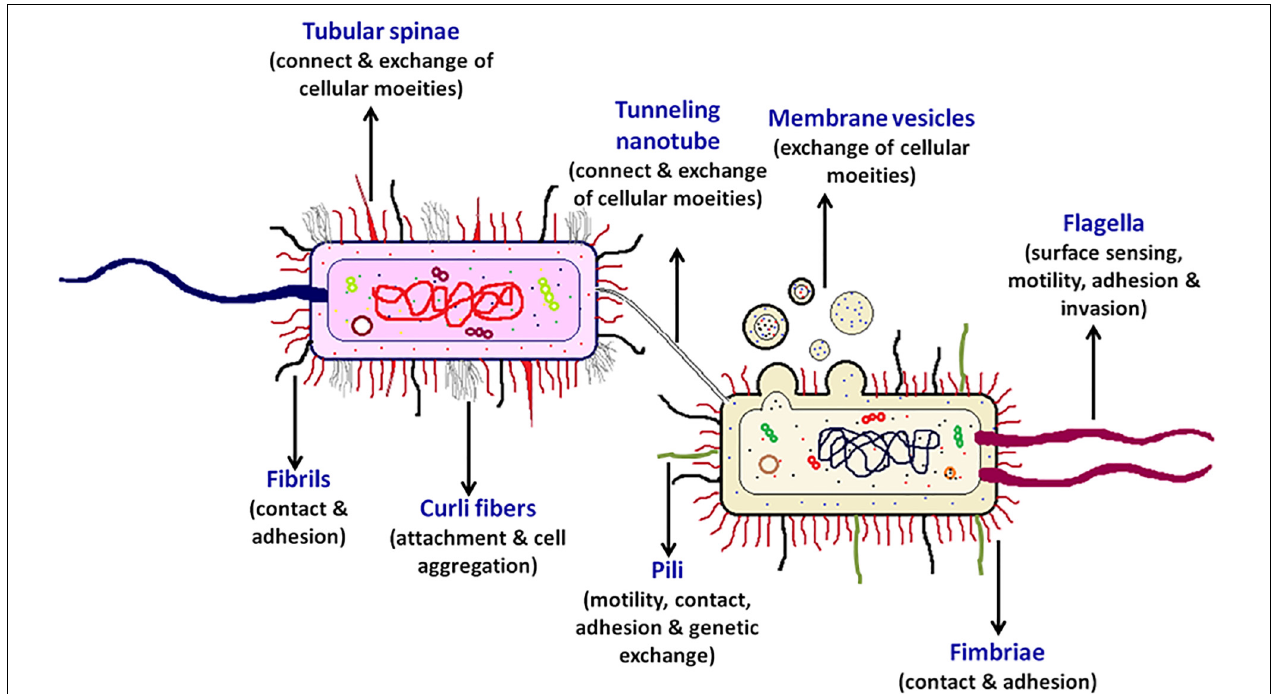
FIGURE 2 | Bacterial cell-surface appendages. Various proteinaceous tubular or fibrous structures are found extending from the surface of bacterial cell wall. These structures help the bacterium in diverse functions such as in locomotion, adhesion, surface attachment, signaling, exchange of effector proteins, and genetic material, etc. Every cell surface appendage plays a specialized role and eventually helps in mediating bacterial communication. The strings like tubular structure flagellum, protruding outward from a bacterium is majorly known for providing motility, surface sensing, adhesion, and invasion. Pili helps in providing twitching motility to the bacterium, helps in adhesion and developing contacts for genetic exchange. The tunneling nanotubes are the tubular structures which help in exchange of cellular moieties in the adjacent cells. Whereas, the spherical shaped membrane vesicles help in exchange and delivery of various cellular moieties even to the far away cells. The curli fibers helps the bacterium in attachment and cell aggregation, the two filamentous surface appendages fimbriae and fibril help in contact and adhesion, the tubular spinae connect the cells and helps in the exchange of cellular